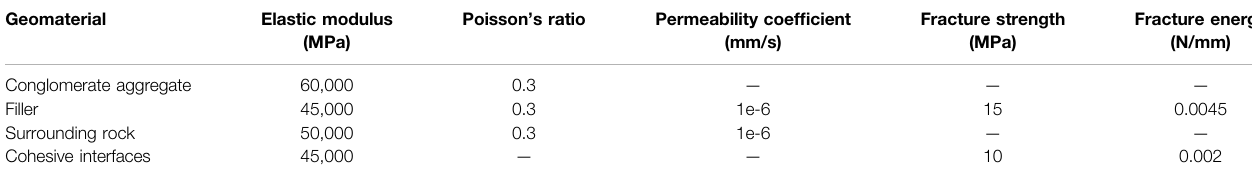
TABLE 1 | Mechanical parameters of the geomaterials used in the numerical simulations. Geomaterial